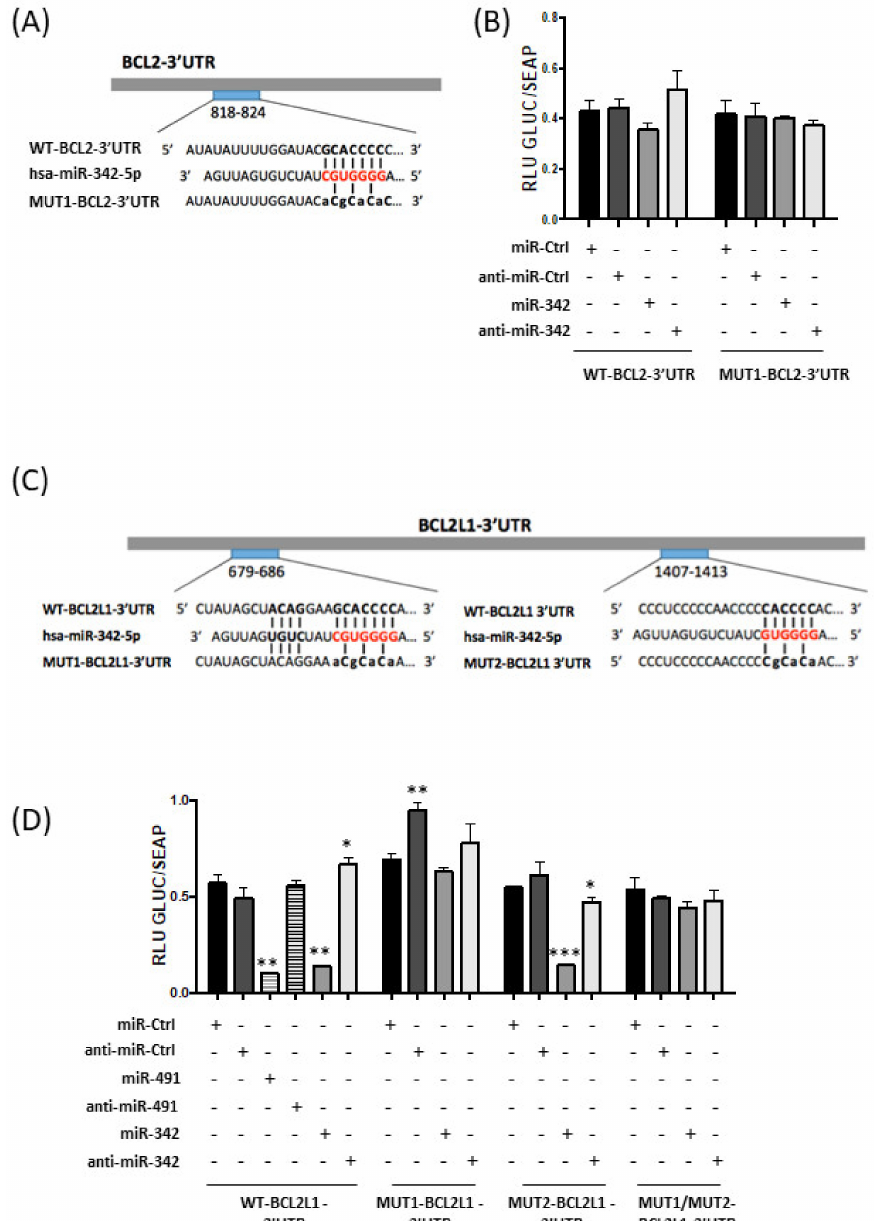
Figure 5. Analysis of inhibition of BCL2 and BCL2L1 mRNAs by miR-491-5p and miR-342-5p in HOS cells. ( A ) Schematic representation of wild-type (WT) and mutant (MUT1) BCL2-3 (cid:48) UTR with their predicted hsa-miR-342-5p binding sites. ( B ) Luciferase reporter constructs containing WT and MUT1 BCL2-3 (cid:48) UTR (1 ng/ µ L) were transfected into HOS cells concomitantly with the indicated miR or anti-miR (20 nM). ( C ) Schematic representation of wild-type (WT) and mutant (MUT1 and MUT2) BCL2L1-3 (cid:48) UTR with their predicted hsa-miR-342-5p binding sites. The MUT1/MUT2-BCL2L1-3 (cid:48) UTR vector contains both mutations 1 and 2. ( D ) Luciferase reporter constructs containing WT and mutant BCL2-3 (cid:48) UTR (2 ng/ µ L) were transfected into HOS cells concomitantly with the indicated miR or anti- miR (20 nM). (B, D) Secreted alkaline phosphatase (SEAP) and Gaussia luciferase (GLUC) assays were carried out 48 h post-transfection. GLUC activity was normalized to SEAP activity and expressed as relative luciferase units (RLU). Representative experiments (mean ± SD) of four independent experiments performed in triplicate are provided. Statistically significant differences between miR- Ctrl and miRNA- or anti-miRNA-treated cells were evaluated using a two-tailed Student’s t -test (***: p < 0.001, **: p < 0.01, *: p <